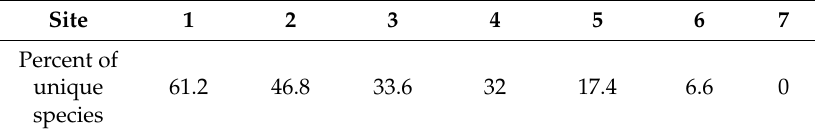
Table 6. Estimator of unique species for communities of algae in the Abraham Lincoln Birthplace National Historical Park waterbodies. The abbreviations for the sites are the same as in Tables 1 and 2. Site